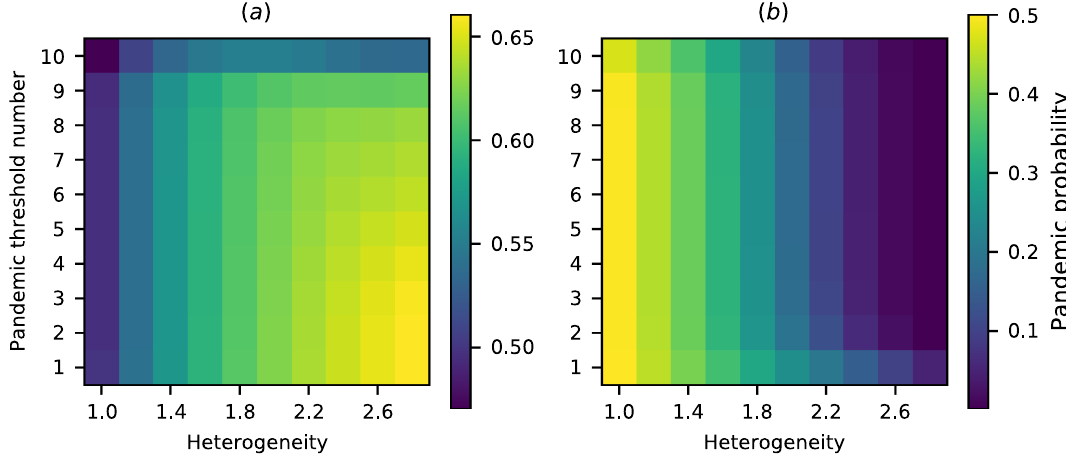
Figure 6. Pandemic probability for various degrees of heterogeneity of transmission rates and a range of transregional pandemic definitions, on a fully connected ten-region network where five regions are classed as higher-transmission and the other five regions are classed as lower-transmission. Note that the colour scales differ between the two plots, in order to make the variation in plot ( a ) clearer. ( a ) Pandemic probability for a pathogen emerging in a higher-transmission region. For low thresholds heterogeneity increases the pandemic probability, but at the 10-region threshold the pandemic probability grows and then decreases with increasing heterogeneity. ( b ) Pandemic probability for a pathogen emerging in a lower-transmission region. At all thresholds increasing heterogeneity decreases the pandemic